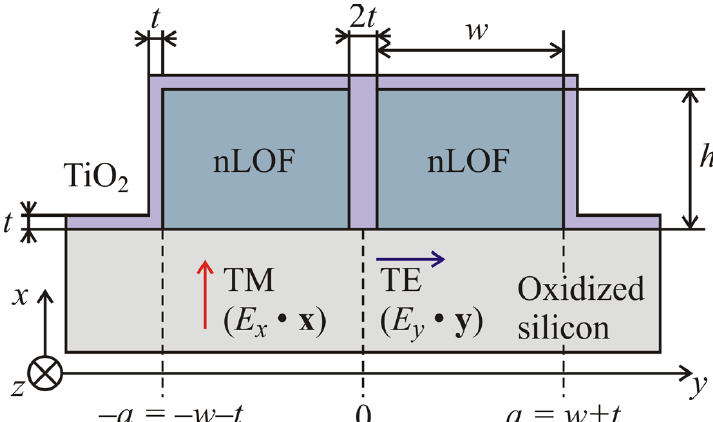
Figure 1. Cross-section geometry of the vertical nano-waveguide. The substrate is an oxidized silicon wafer. The polymer is AZ-nLof. The coating is TiO 2 . The coating thickness is t , the height and width of each part of the polymer region are h and w , respectively. The trench thickness is 2 t and its position with respect to the waveguide is at y T = 0 when